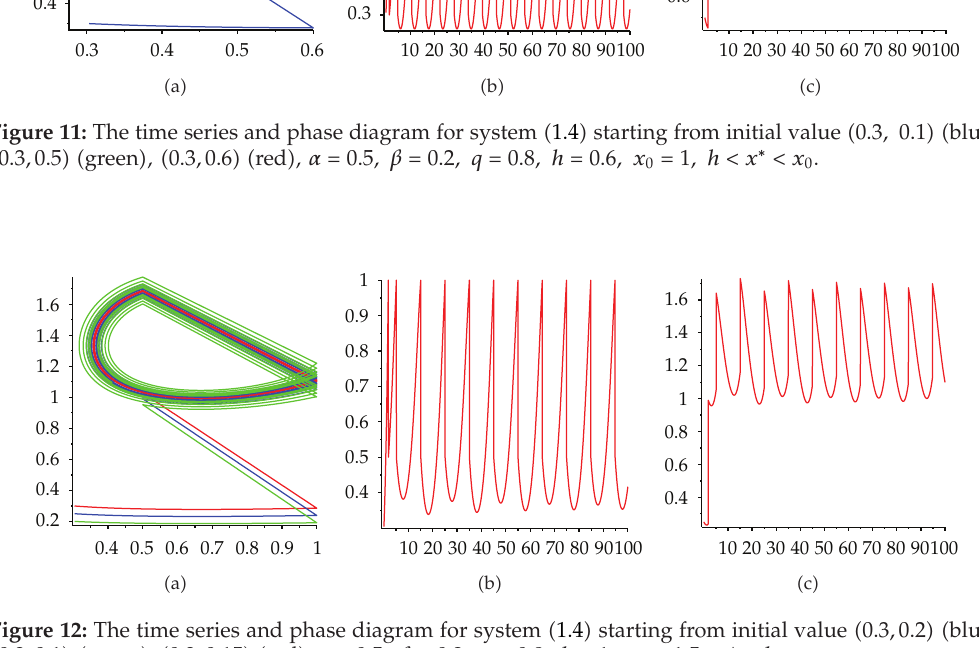
(cid:8) 1 . 5 , x ∗ < h < x 0 0 .